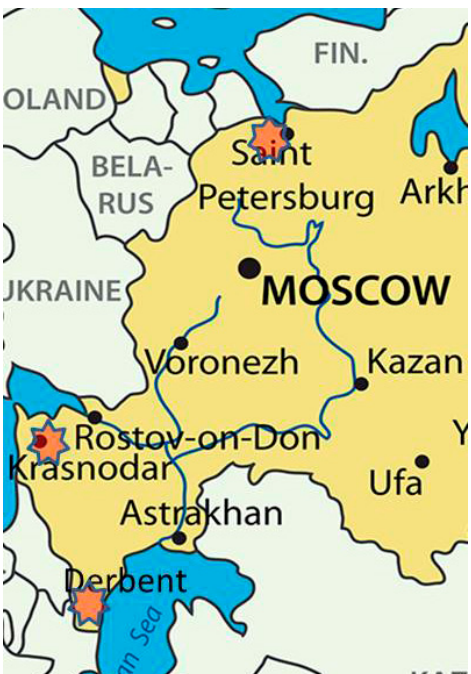
Figure 4. Collection sites of Puccinia striiformis in Russia. Table 5. Sampling details of isolates in regional collections of P. striiformis.